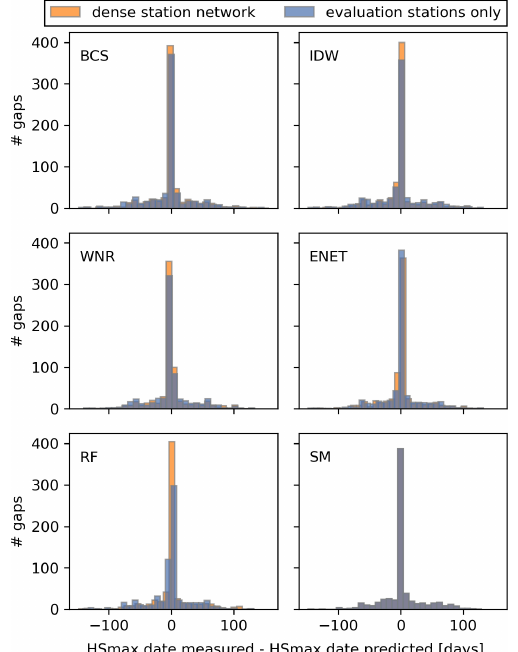
Figure A3. Histograms showing the difference in days between the measured date of HSmax and the date of HSmax in the reconstructed winters in the dense and sparse station networks. In the case that the same HSmax is recorded on more than one day, the date of the first occurrence is taken.